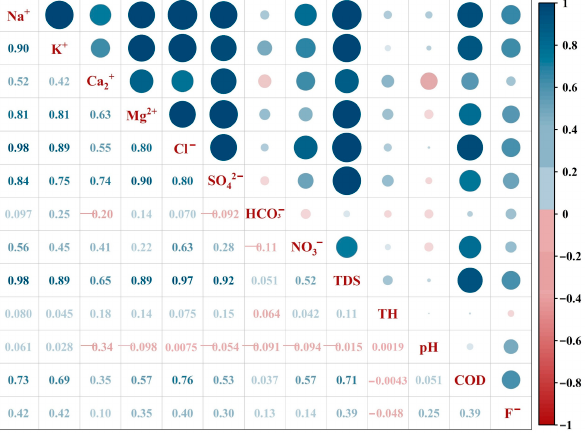
Figure 4. Correlation matrices between parameters.